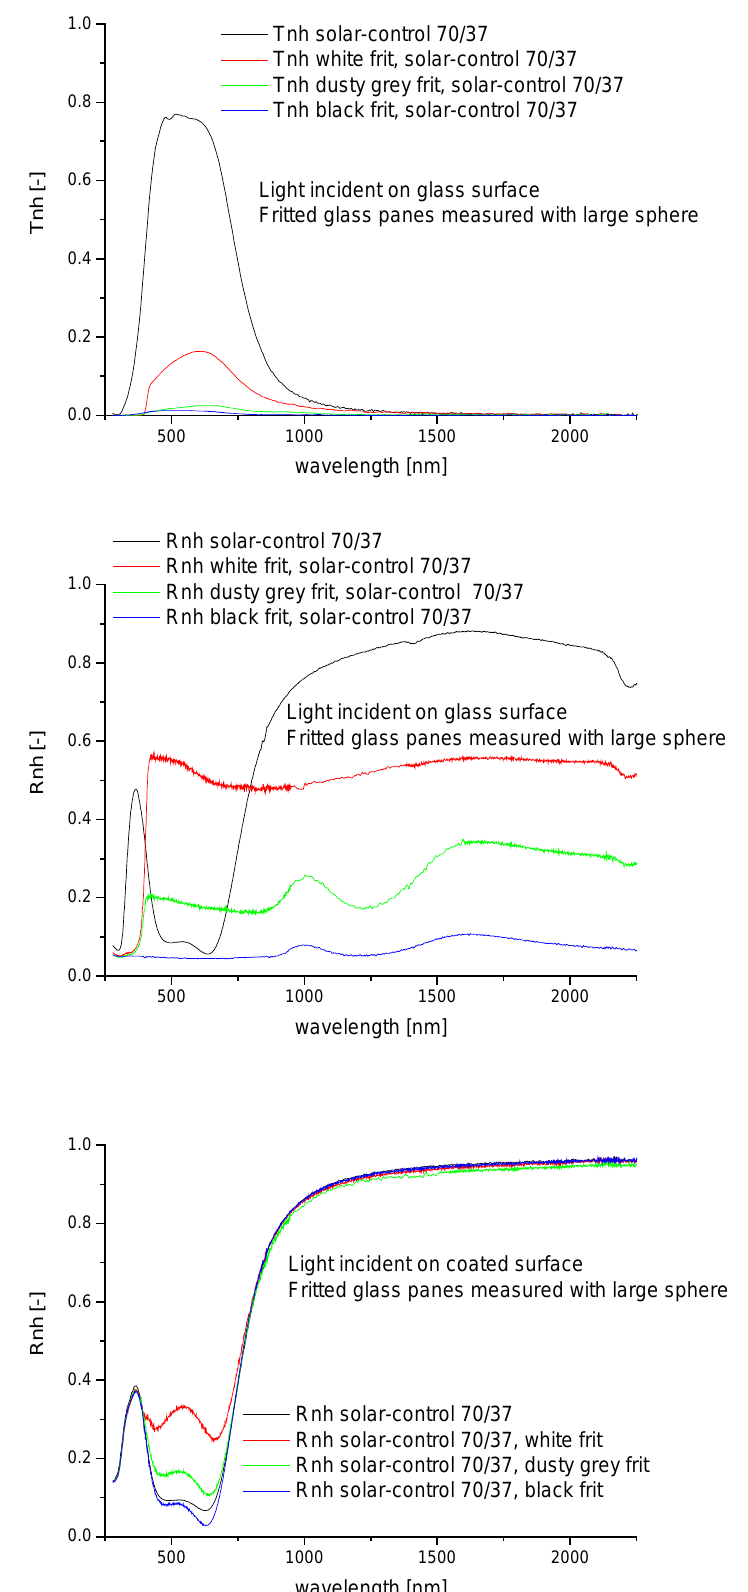
Fig. 5 Spectra for normal-hemispherical transmittance (Tnh; upper graph) and reflectance (Rnh; middle and lower graphs) for 8 mm low-iron glass panes with white, dusty-grey and black fritted coatings combined with a thin-film solar-control coating. An integrating sphere of 620 mm diameter was used for the